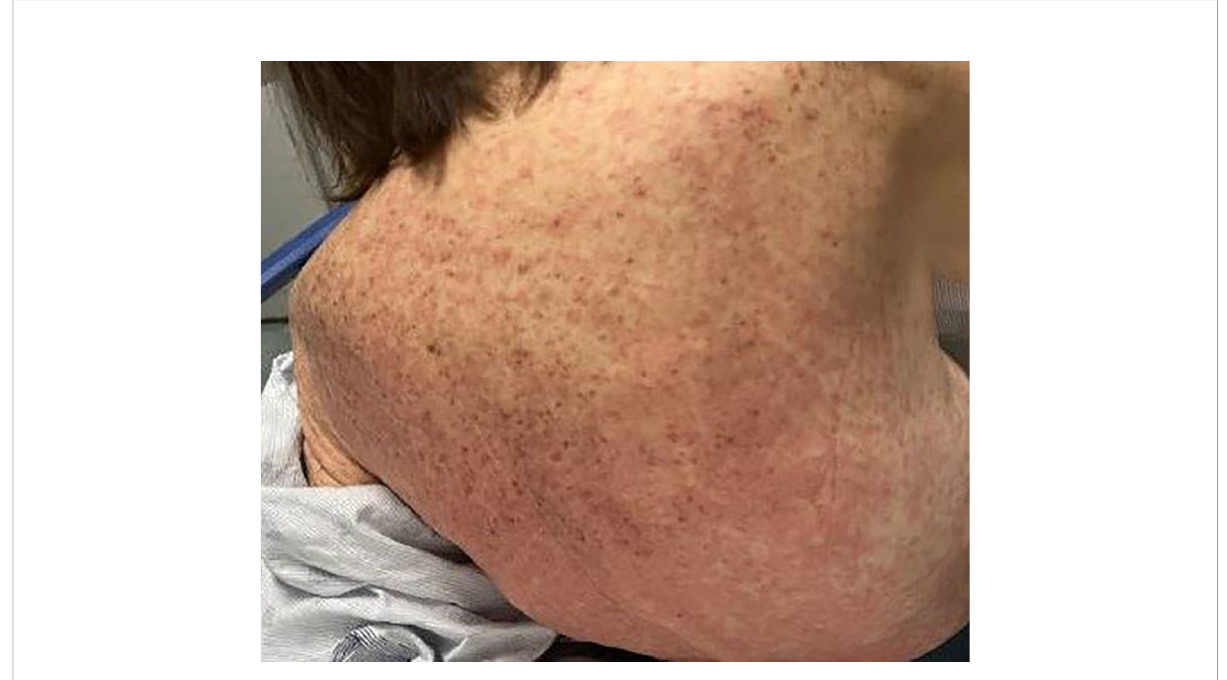
FIGURE 2 Morbilliform rash and blanching erythema on the trunk.